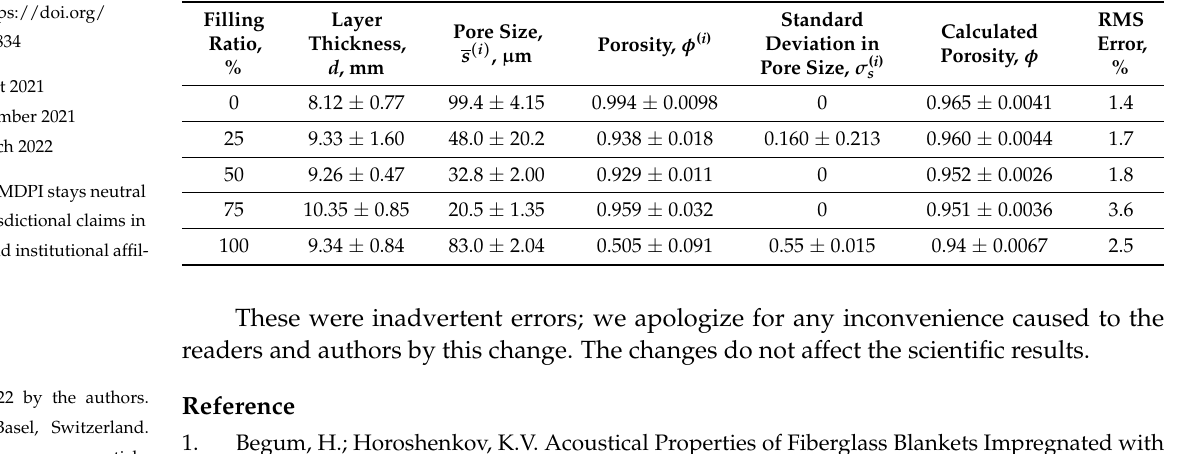
Table 1. Values of the non-acoustical parameters inverted from fitting the model [28] to the measured complex reflection coefficient data for the five types of fiberglass